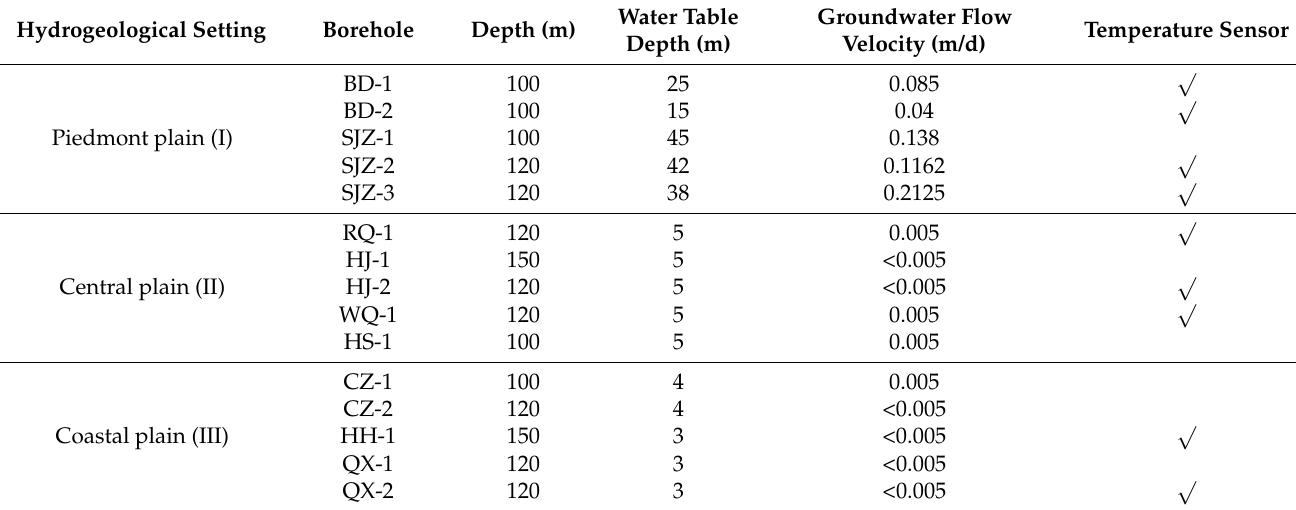
Table 2. Borehole and equipment installation